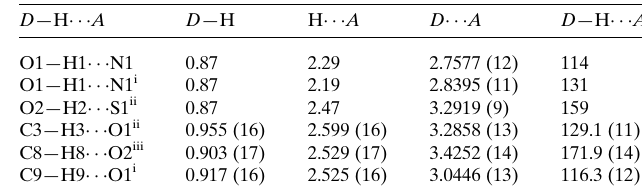
Table 1 Hydrogen-bond geometry (A˚ , (cid:3) ).